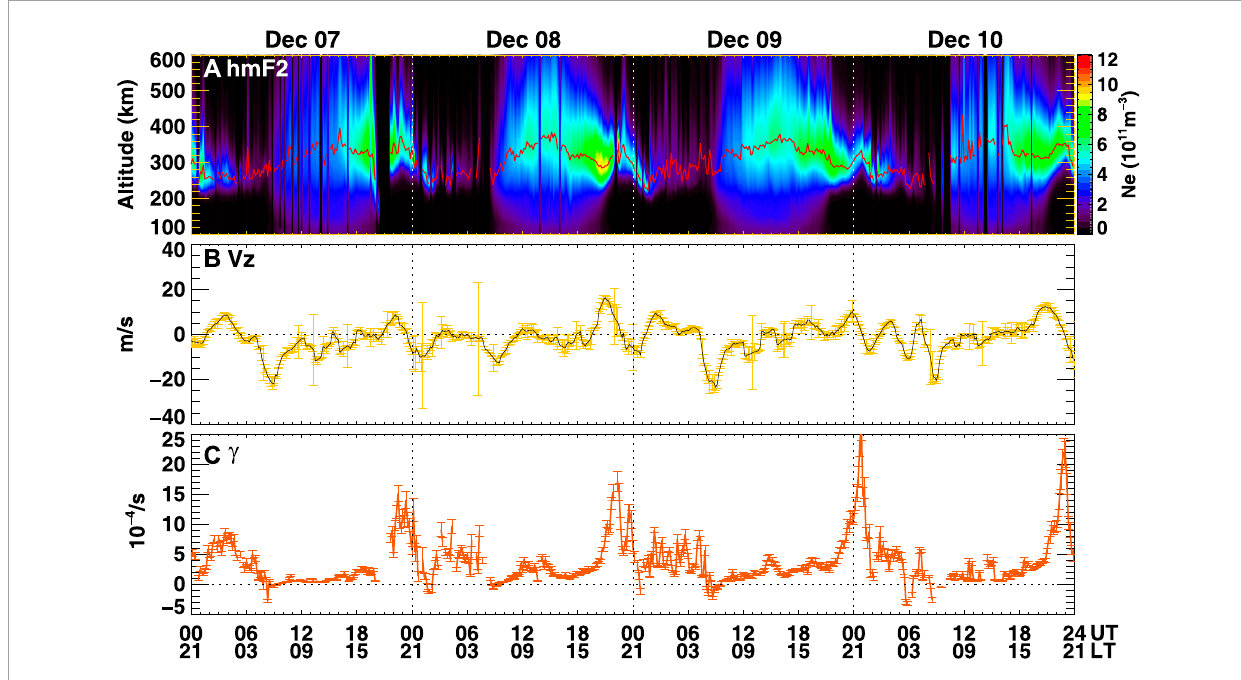
FIGURE 4 Sao Luis ionosonde measurements of (A) electron density profiles and F2-layer peak height (hmF2) as well as (B) F-layer vertical plasma drift with error bars during December 07–10, 2019. (C) Temporal variation of the corresponding linear growth rate of R-T